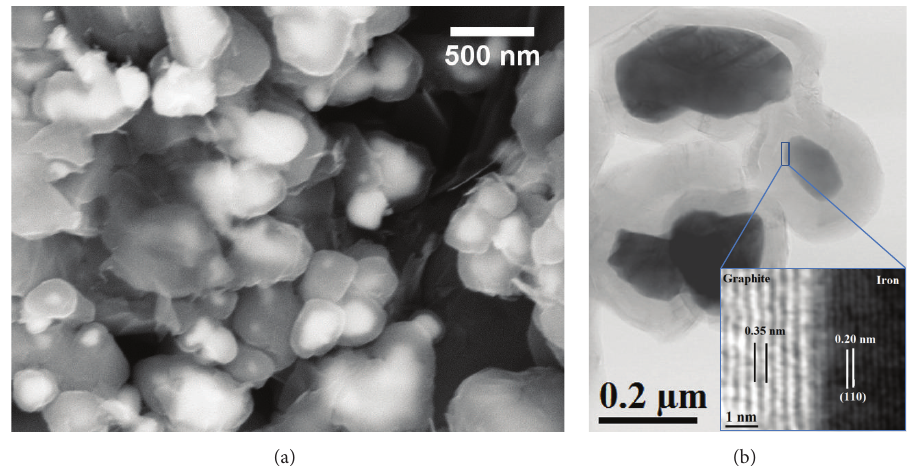
Figure 1: (a) SEM image of a GFeNps sample as obtained from the CVD process and (b) HRTEM image of a GFeNp. The inset shows details on the GFeNps core-shell structure. Note that 0.35 nm and 0.206 nm agree well with the interplanar separation of graphite layers and (110) planes of Fe, respectively.